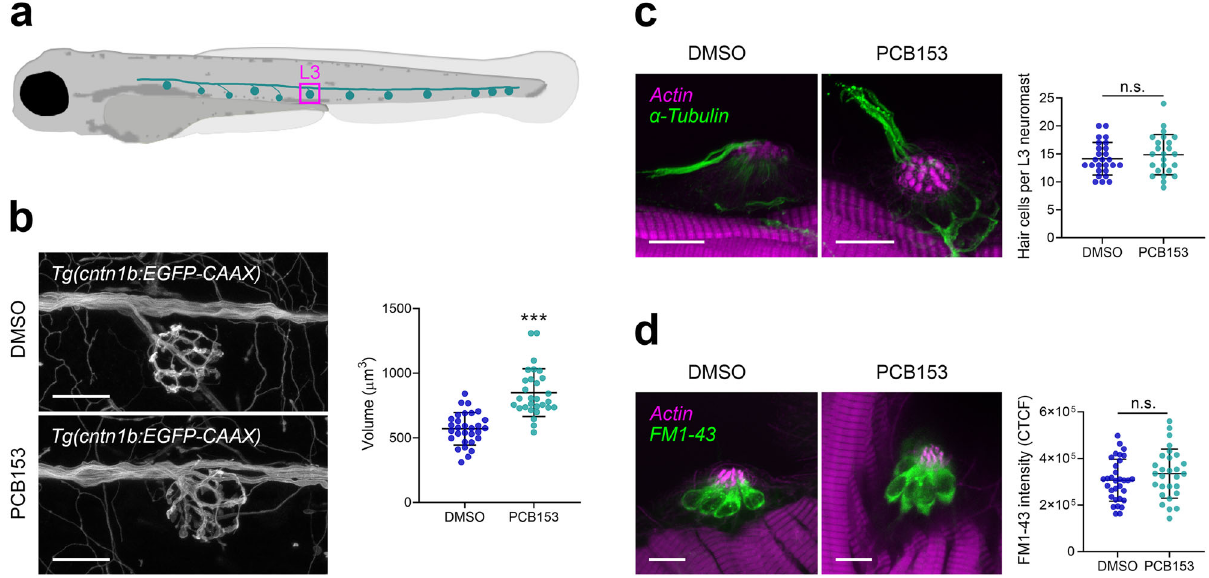
Fig. 3 Effect of PCB153 on morphology and function of lateral line hair cells and innervating neurons. a Diagram indicating L3 neuromast. b Hair cell innervating neurons at neuromast L3 shown using Tg(cntn1b:EGFP-CAAX) and volume of hair cell innervating neurons of DMSO ( n = 30) and PCB153 ( n = 29) treated larvae. Scale bar = 20 µ m. c Whole-mount immunostaining of kinocilia and hair cell innervating neurons (anti-acetylated tubulin antibody; green) and counterstain of stereocilia bundles and muscle tissue (actin; magenta) of DMSO ( n = 26) and PCB153 ( n = 24) treated larvae. The hair cell number was determined based on the number of kinocilia. Scale bar = 10 µ m. d Uptake of FM1-43 dye as indication of functional hair cells of DMSO ( n = 32) and PCB153 ( n = 28) treated larvae. CTCF = Corrected total cell fl uorescence. Scale bar = 10 µ m. All data points are biologically independent samples from three independent experiments and mean ± SD are shown in the plots. Unpaired two-tailed t -test with Welch ’ s correction was used for statistical analysis in ( b , c ), a two-way ANOVA accounting for trial and treatment in ( d ). Asterisks indicate signi fi cant differences to controls (*** p <